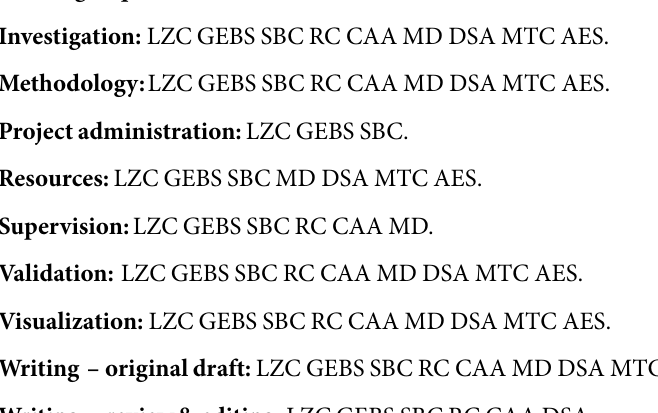
S2 Fig. Ultrastructuralchanges observedin dogs from the carcinoma group. Weakly elec- tron-dense mesangial deposit in upper capillary loop (open arrowhead) and effacement of the podocytefoot processes was often seen (black arrows). Original magnification, x120000. S1 Table. Number of dogs that had positive IF labeling with antibodies against canine IgG, IgM, IgA and